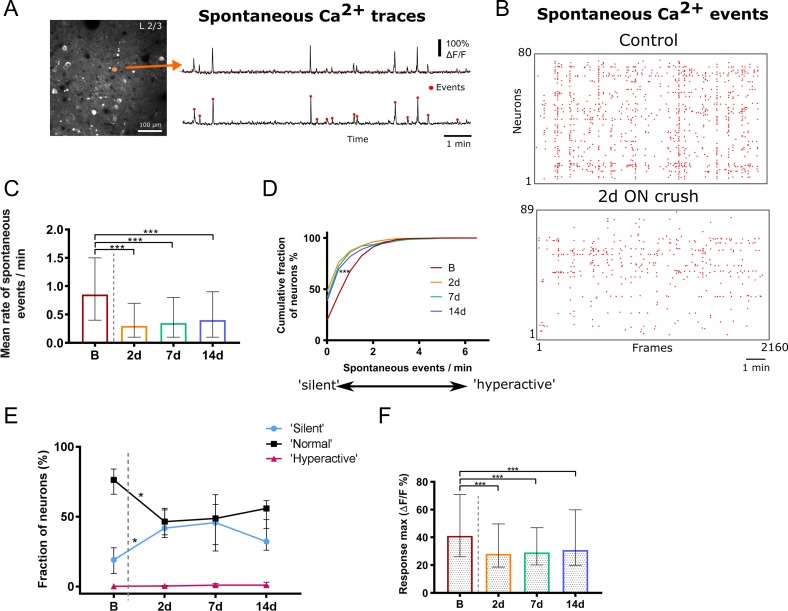
Spontaneous activity in L2/3 of V1b after unilateral ON crush. (A) In vivo 2-photon microscope image showing a typical field of view of GCaMP6s labeled neurons in L2/3 of V1b (left). Orange circle is indicating a cell mask that was used to extract spontaneous Ca2+ fluorescence traces shown on the right (top trace). Significantly spontaneous events (red circles) were then detected from 10 min recording (bottom trace) as described in methods section. (B) Raster plot of detected spontaneous Ca2+ events of all identified neurons in a single field of view before (top) and 2d after (bottom) unilateral ON crush in the same animal over 10 min of recording. (C) The mean rate of spontaneous events and (D) normalized frequency distribution of all detected spontaneous events after the ON crush. The rate is expressed as spontaneous events per neuron per minute (B vs. all post crush time points, ***P < 0.001). (E) Quantification of mean fractions of “silent” (0–0.25 events/min), “normal” (0.25–4 events/min) and “hyperactive” (>4 events/min) among all detected spontaneous events, before and after ON crush (“silent” B vs. “silent” 2 d, *P = 0.015; “normal” B vs. “normal” 2 d, *P = 0.013). (F) Maximum response magnitudes of spontaneous events after the ON crush (B vs. all post crush time points, ***P < 0.001). (C–F) B, n = 1040 neurons, 6 mice; 2 d, n = 797 neurons, 5 mice; 7 d n = 448 neurons, 4 mice; 14 d n = 686 neurons, 4 mice; (C, E, F) Kruskal–Wallis test with Dunn’s post hoc test. Data are presented as median and IQR.